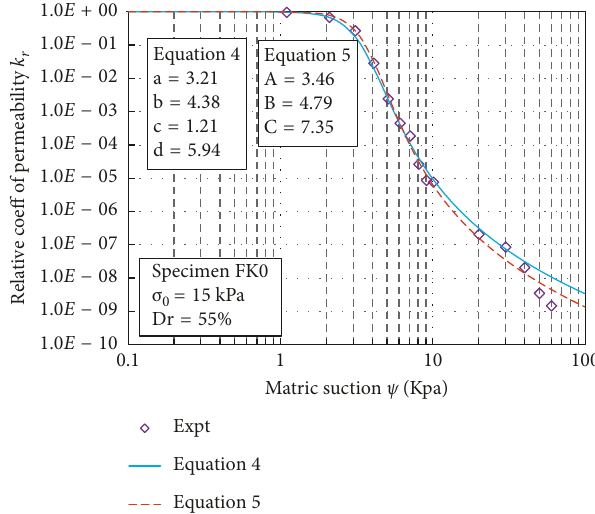
Figure 5: Permeability coefficient changes against matric suction for soil